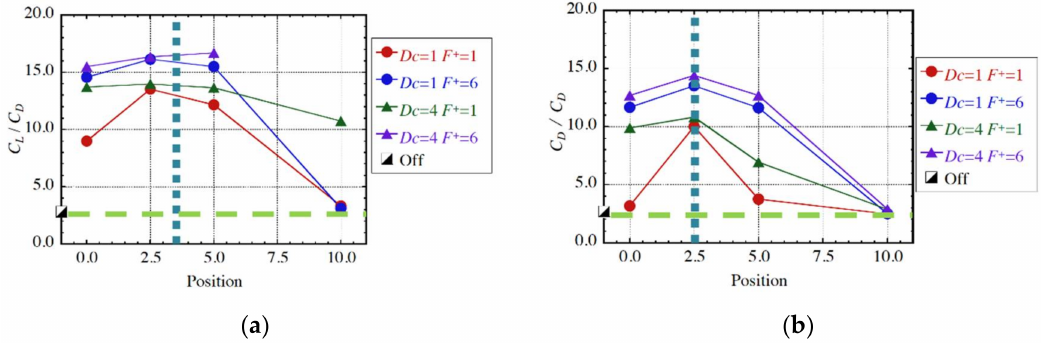
Figure 7. Effect of DBD plasma actuator position for NACA0015, α = 14 ◦ , BR = 10%, and Re = 6.3 × 10 4 [45]: ( a ) α = 12 ◦ ; and ( b ) α = 14 ◦